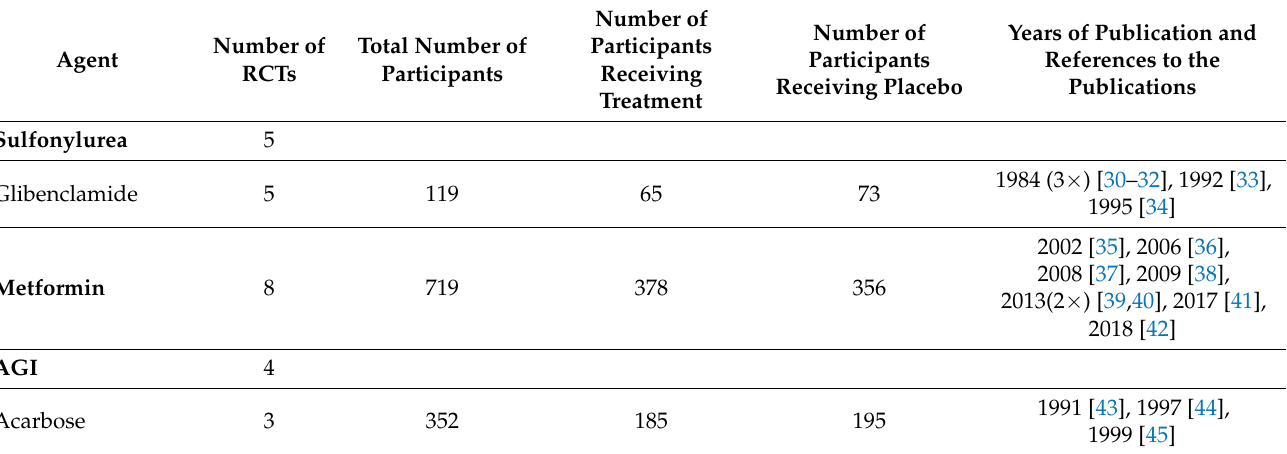
Figure 1. Summary of randomized controlled trials applying adjunct glucose-lowering therapies to insulin in people with T1D. The numbers in braces and the thickness of the lines, which connect the compared agents (or placebo) indicate the number of studies conducted (as modified from Avgernios et al. [29]). The black side bars refer to the chronological sequence of year of market introduction for the use in patients with T2D of the respective substance class (modified from Kahn et al. [28]). AGI = Alpha-glucosidase inhibitors; DPP4-i = Dipeptidyl-peptidase-4 inhibitors; GLP1-RA = Glucagon-like peptide-1 receptor agonists; SGLT2-I = Sodium-glucose linked transporter-2 inhibitors; TZD = Thiazolidinediones (TZD). Table 1. Summary of the number of randomized placebo-controlled trials and study participants. AGI = Alpha-glucosidase inhibitors; DPP4-i = Dipeptidyl-peptidase-4 inhibitors; GLP1-RA = Glucagon-like peptide-1 receptor agonists; SGLT(1)2-i = Sodium-glucose linked transporter-(1)2 inhibitors; TZD = Thiazolidinediones (TZD).